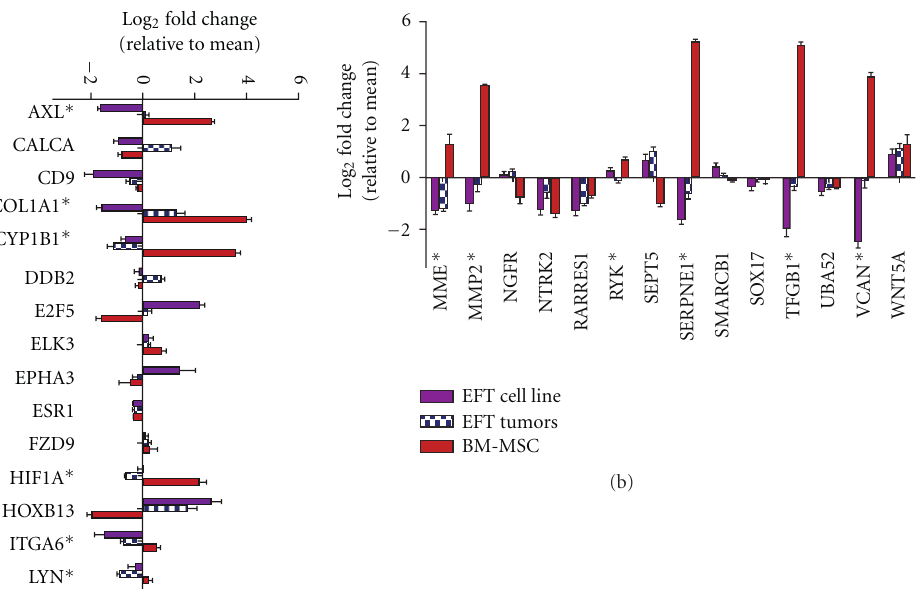
Figure 4: Gene expression in primary EWS tumors, cell lines, normal adult tissues, and hMSCs. Normalized A ff ymetrix gene expression data from 10 EWS cell lines (purple boxes), 32 EWS primary tumors (hatched purple boxes), 11 adult tissues (each in triplicate; green boxes), and 3 hMSC primary cultures (red boxes) were analyzed, and 29 of 36 hypermethylated genes were found to be di ff erentially expressed among the 4 cell/tissue types (FDR < 0.05). Mean expression in each group is plotted relative to the mean expression level in all samples (error bars represent standard error of the mean). Asterisks denote the 12 genes that showed decreased expression in EWS primary tumors compared to hMSC ( P < 0 .